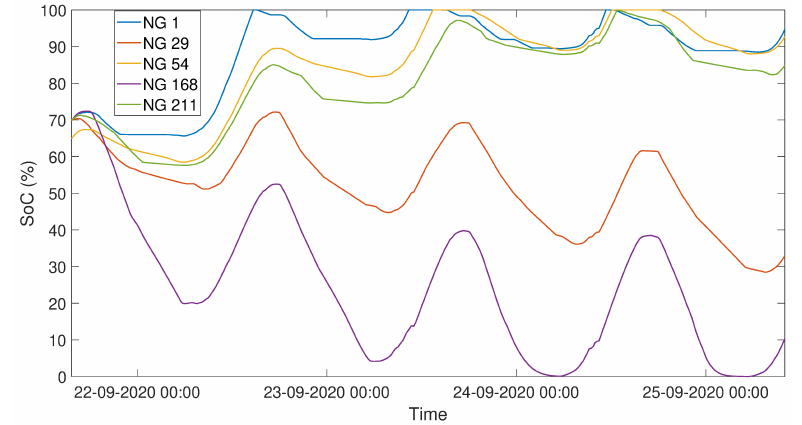
Figure 12. Evolution of the SoC of the NGs without a microgrid.